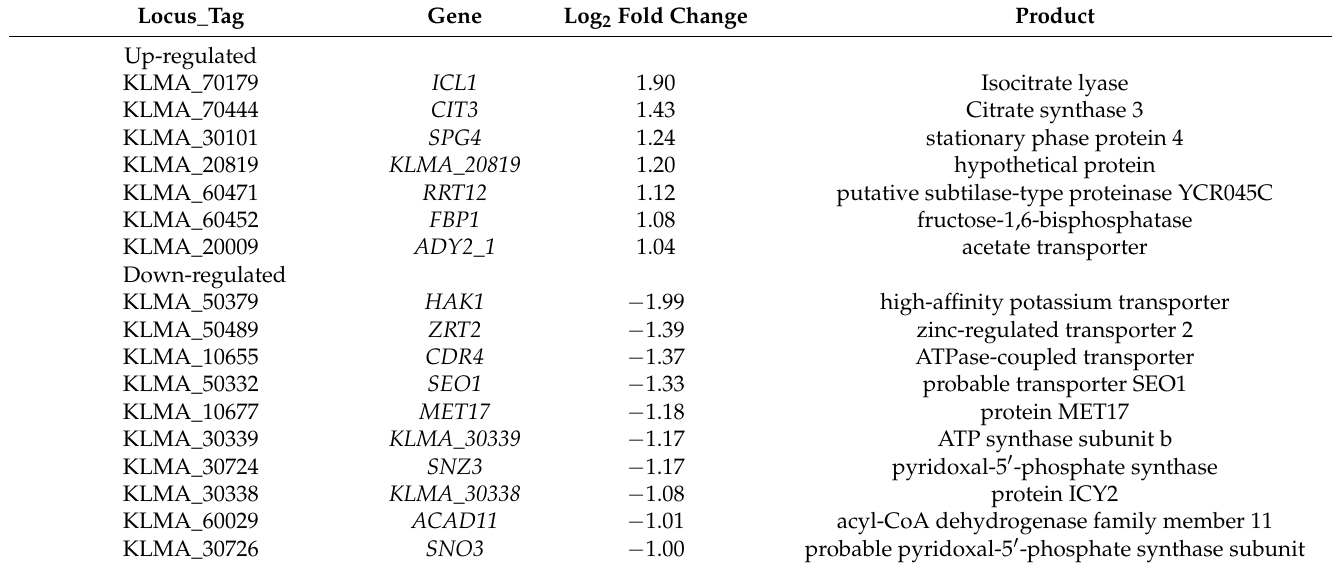
Table 3. Up-regulated (log 2 > 1) and down-regulated (log 2 < − 1) genes in ACT001